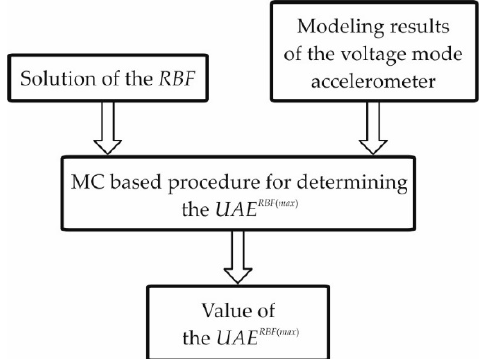
Figure 2. Block diagram of the procedure intended for determining the UAE RBF ( max ) .